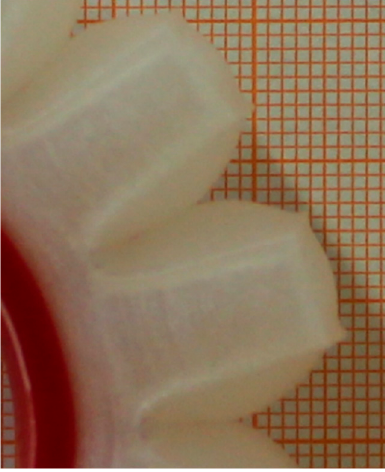
Figure 13. Zoom of an R-type MBP showing its behavior when pressurized.